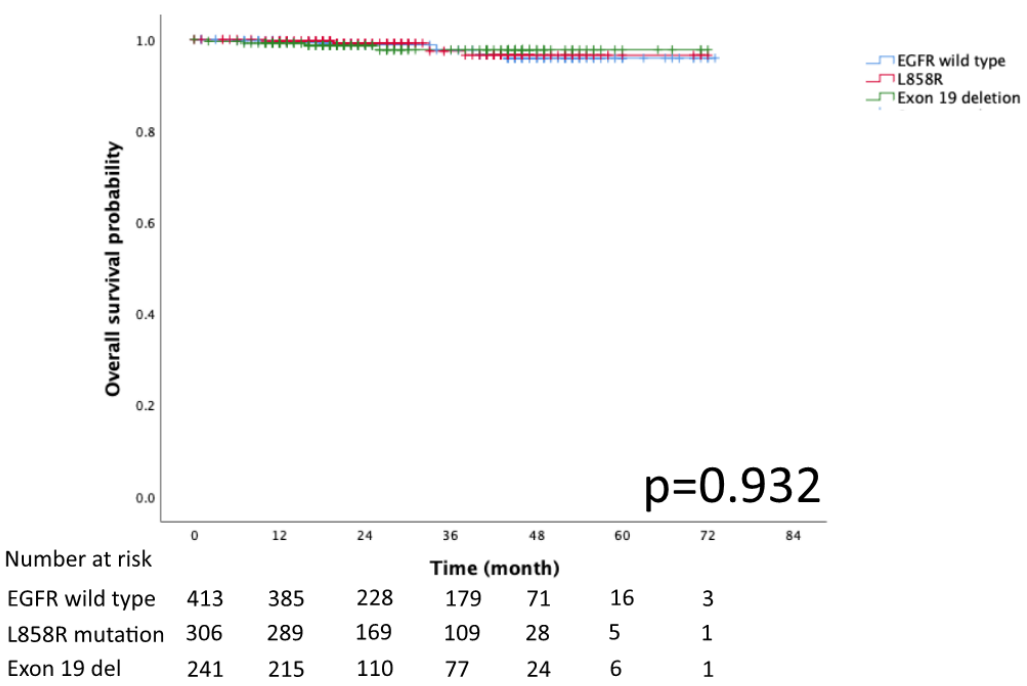
Figure 2. Kaplan – Meier curve of EGFR wild type, Exon 19 del, and L858R disease free survival.